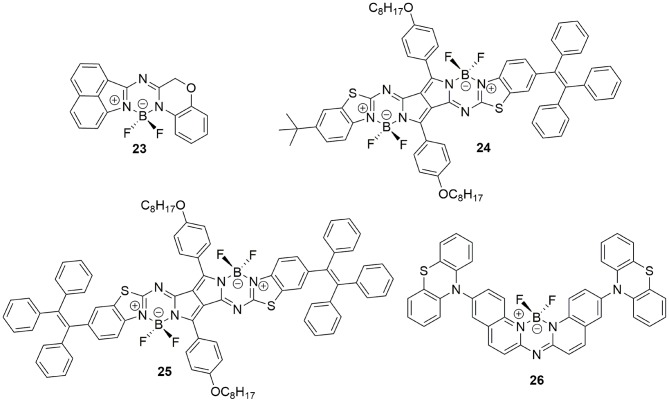
Chemical structures of compounds 23–26.